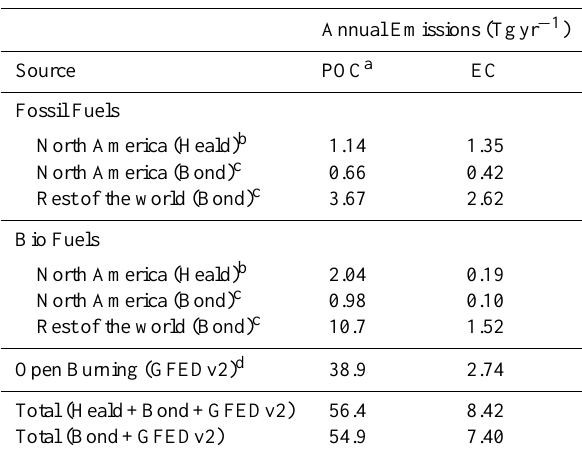
Table 2. Annual emissions of POC and elemental carbon (EC) by source